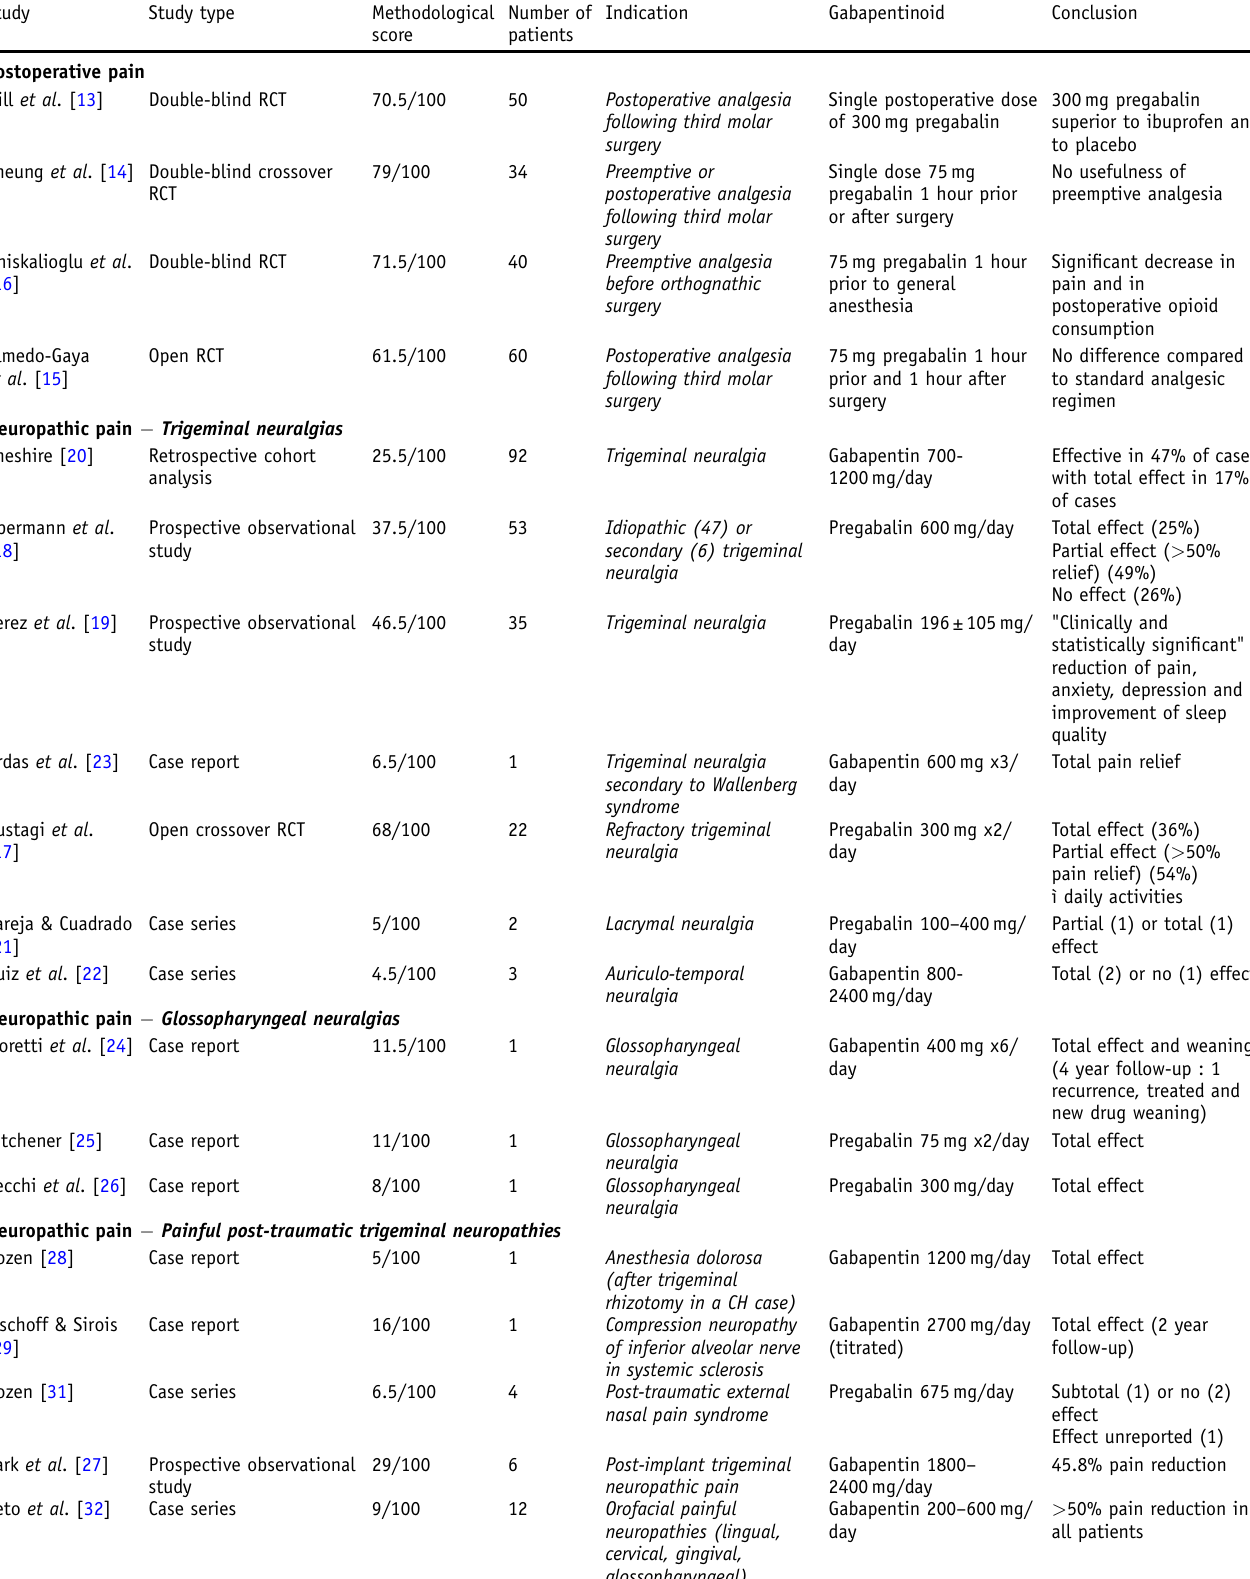
Table III. Scoping review results (cid:1) Gabapentinoids in the management of orofacial